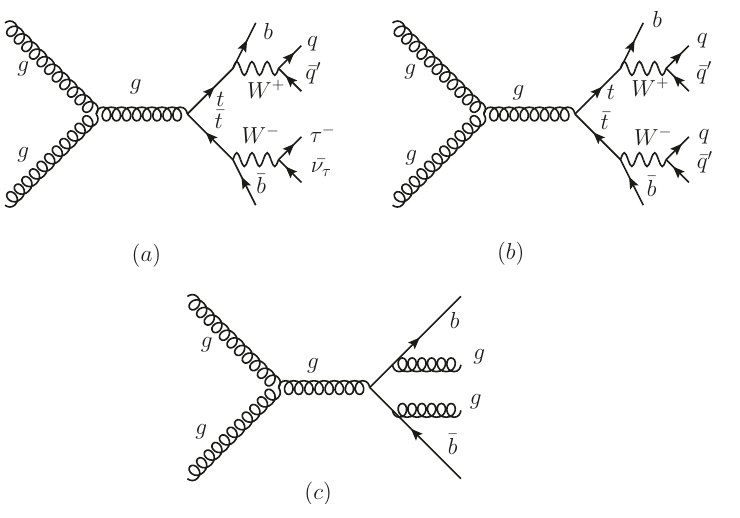
Figure 14 . Feynman diagrams for the dominant (a) semi-leptonic t (cid:22) t , (b) fully hadronic t (cid:22) t and (d) b (cid:22) bjj (where jet (j) can fake as (cid:28) jet) background for the b (cid:22) b(cid:28)(cid:28)